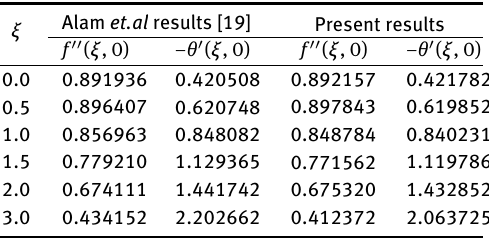
Table 1: Numerical values of skin-friction and heat transfer coef- ficient for different values of ξ while Pr =0.71, S f =0.5 and S T =1.0 when β → ∞ (Newtonian case).